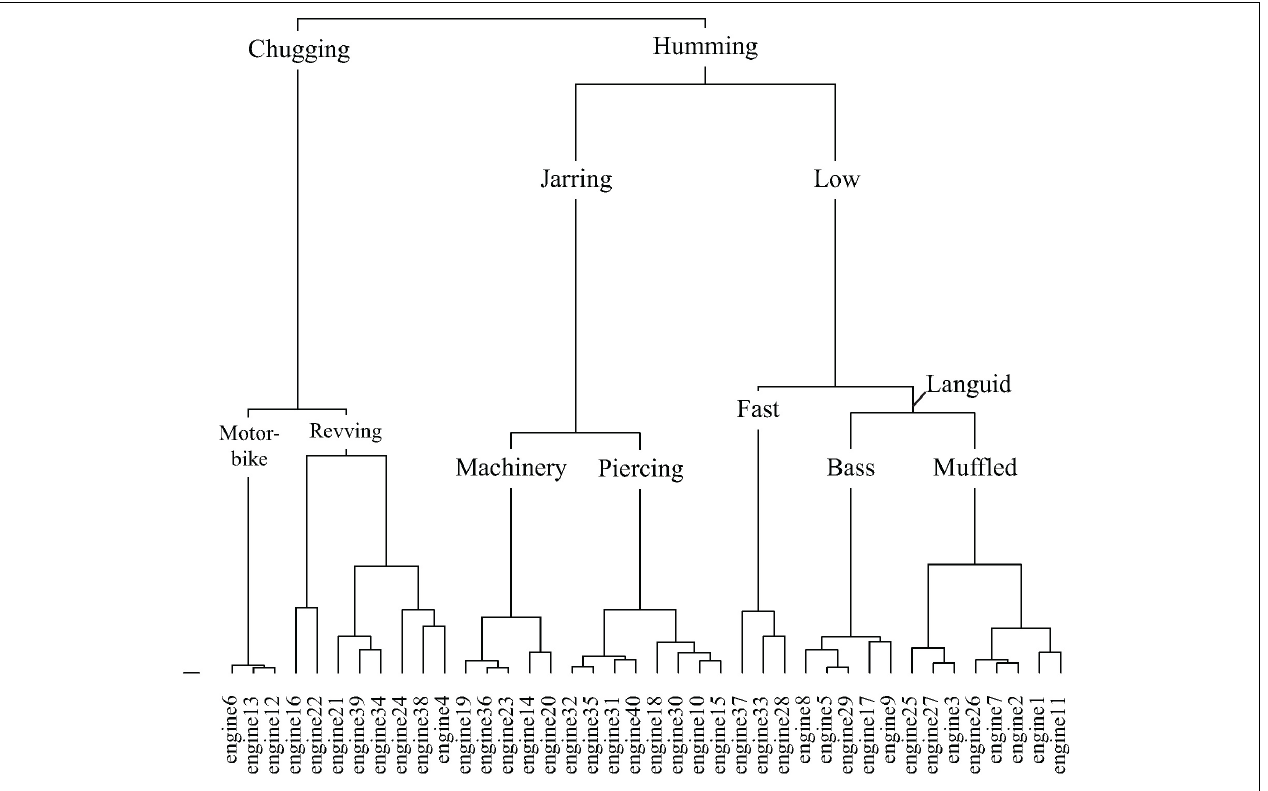
FIGURE 10 | The engine taxonomy generated by hierarchical cluster analysis of the principal dimensions resulting from correspondence